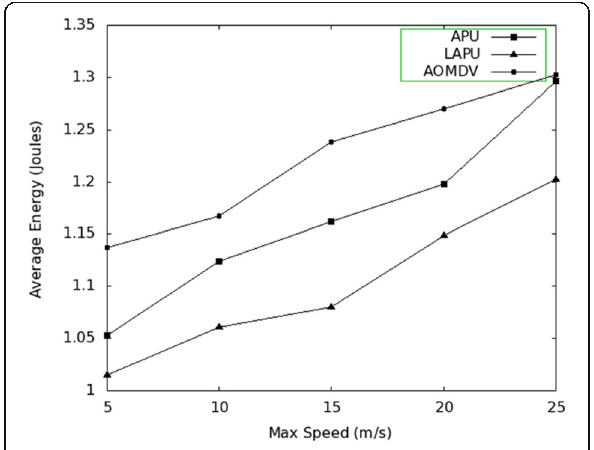
Fig. 6 Throughput vs. node mobility